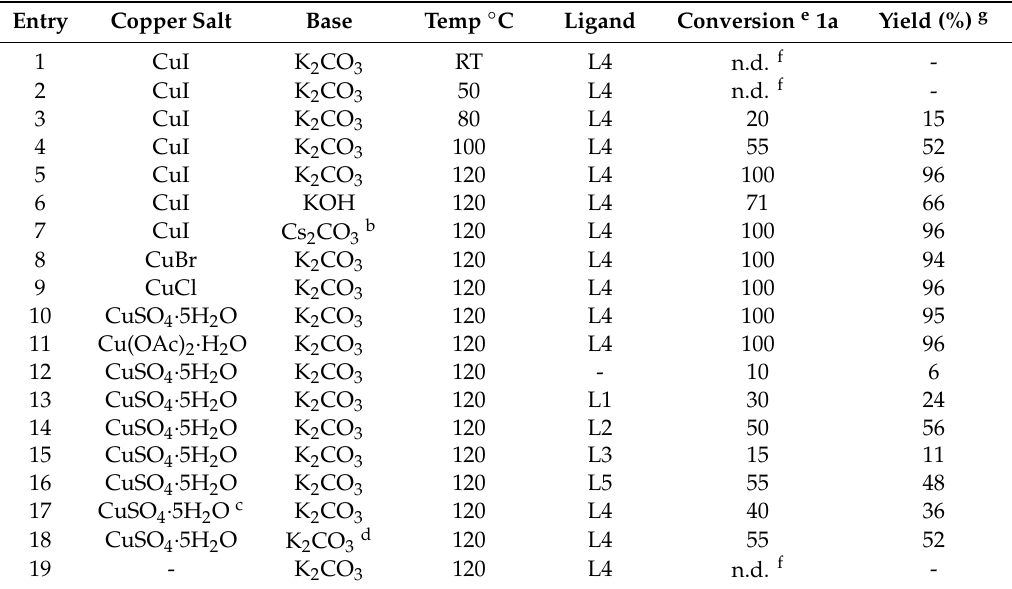
CuSO 4 · 5H 2 O 15 CuSO 4 · 5H 2 O K 2 CO 3 120